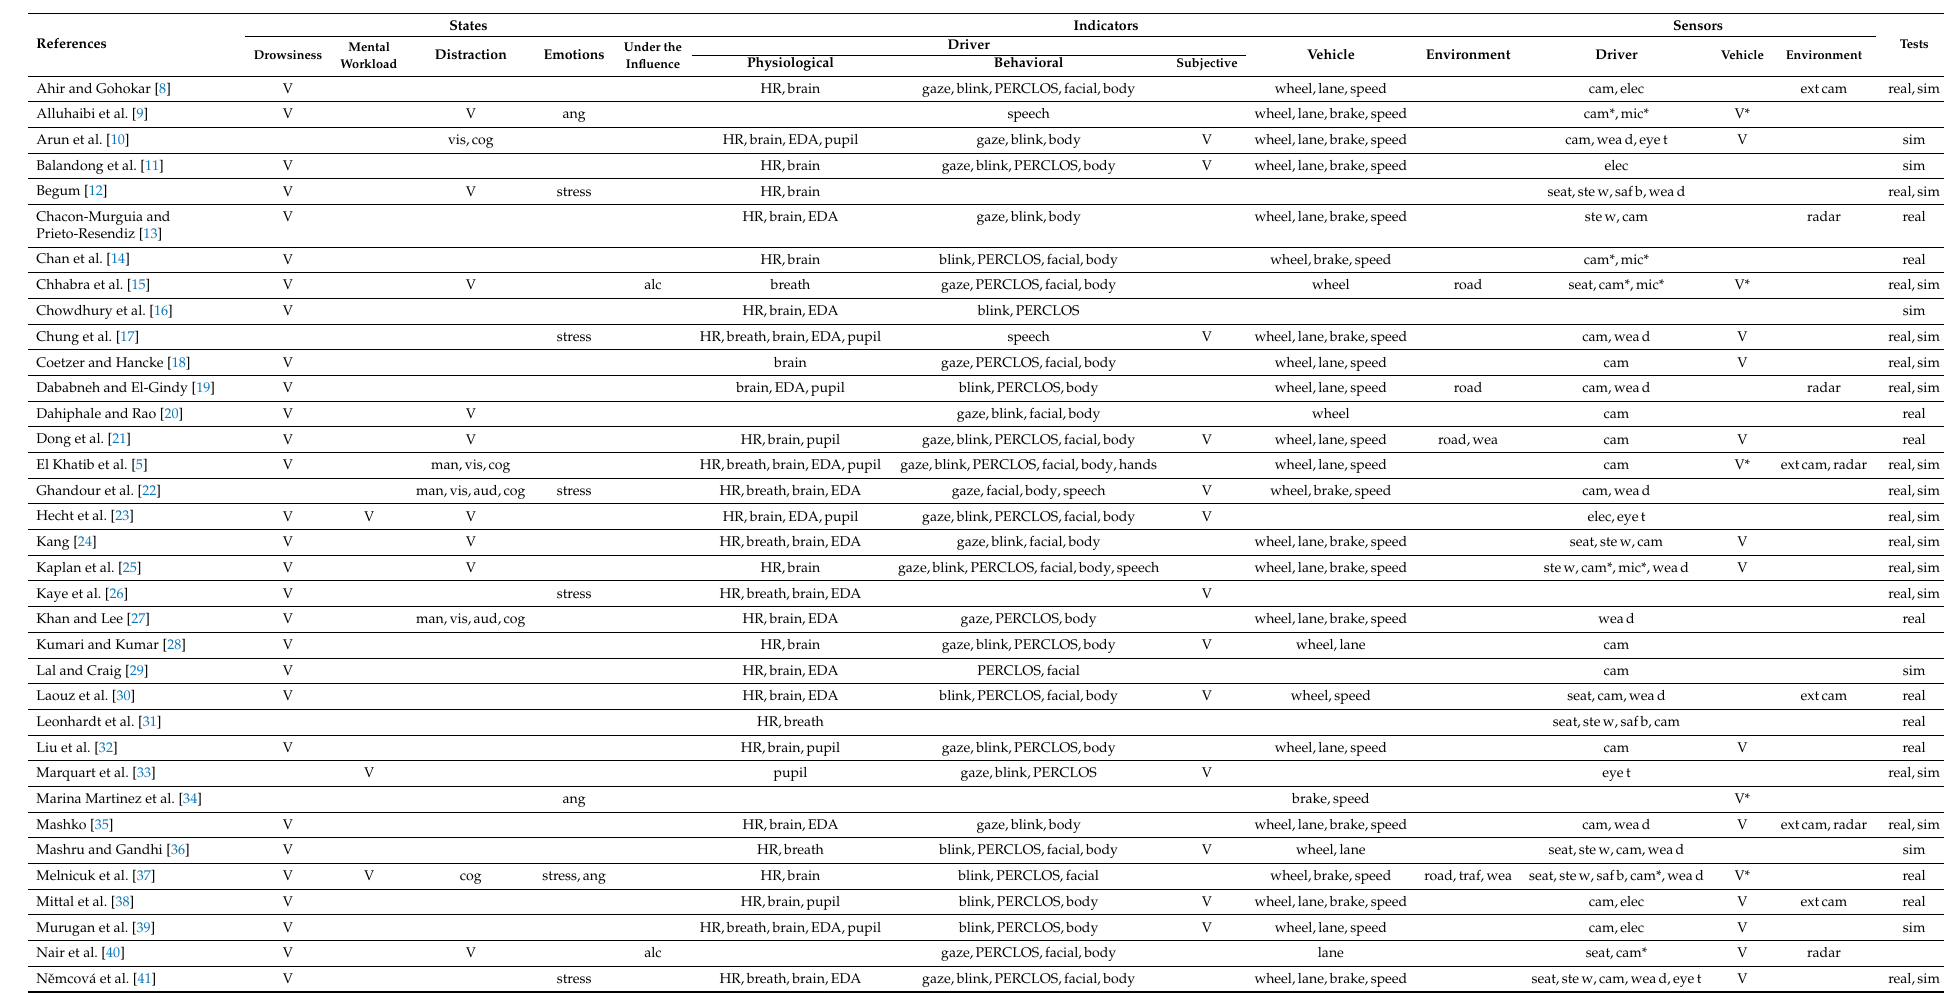
Table 2. The first column of the table lists, by alphabetical order of first author, the 56 references that resulted from our survey on driver monitoring (DM) and related systems (DMSs). The next three megacolumns and the last column briefly describe, for each reference, the states, indicators, sensors, and test conditions considered